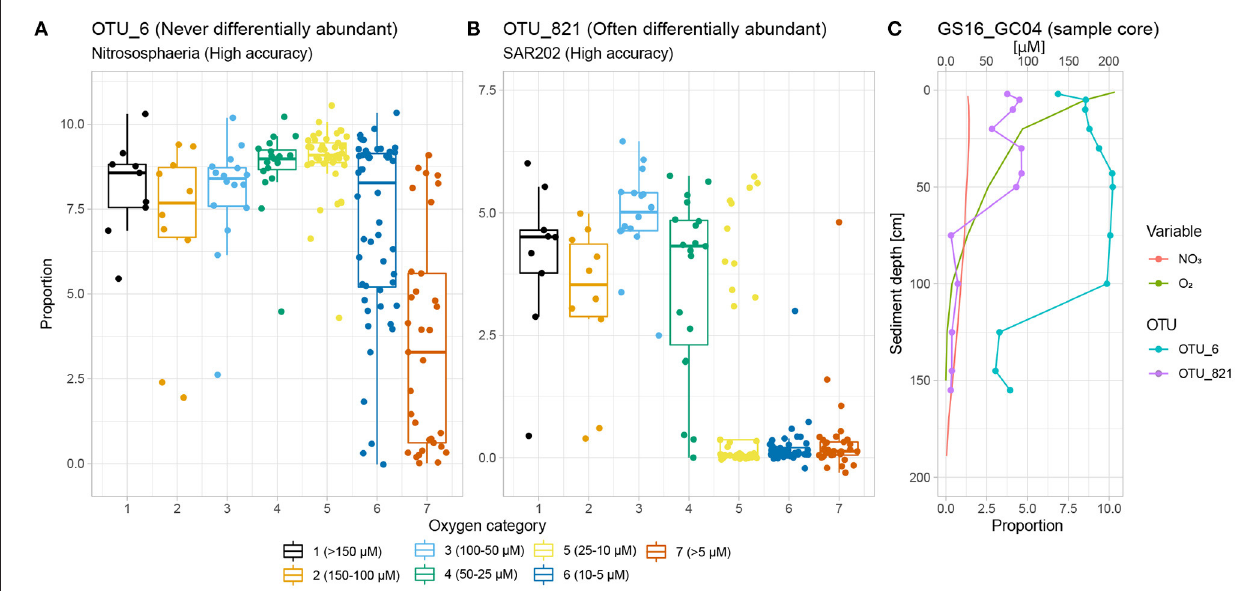
FIGURE 5 | Classification rates vs. differential abundance. (A) OTU_6 belongs to Nitrososphaeria, which is a very strong SVM classifier. It is, however, never differentially abundant with regards to the oxygen gradient. This is because its large spread in relative abundance within categories 6 and 7 increases the within-group VLR against any other OTU (i.e., high θ d ). (B) OTU_821 (SAR202, Chloroflexi), on the other hand, exhibits a threshold response to declining oxygen concentration and is clearly differentially abundant between categories 1 vs. 6 and 7 by the settings of this study. Within-group variability for categories 1 (high relative abundance), 6 and 7 (low relative abundance) are all low, indicating that OTU_821 will contribute to low within-group and high between-group VLR when paired with other OTUs (i.e., low θ d ). (C) GS16_GC04 exemplifies the two OTUs’ different behaviour with regards to the oxygen gradient, both of which nevertheless result in high classification rate with